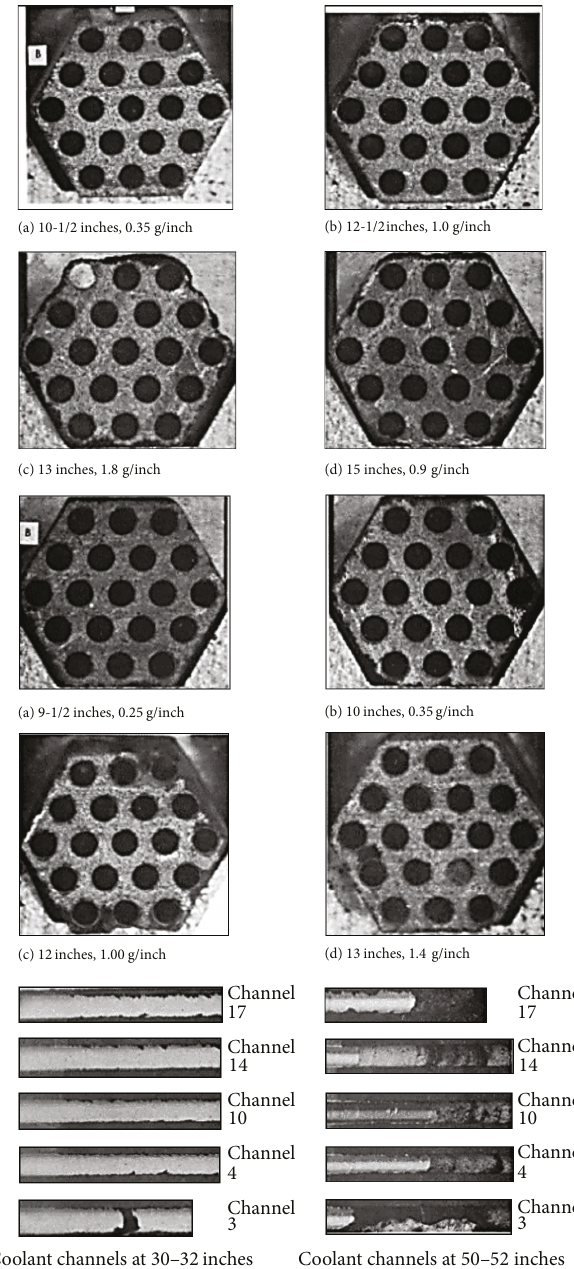
Figure 4: Fuel element corrosion along the axial length of channels and faces